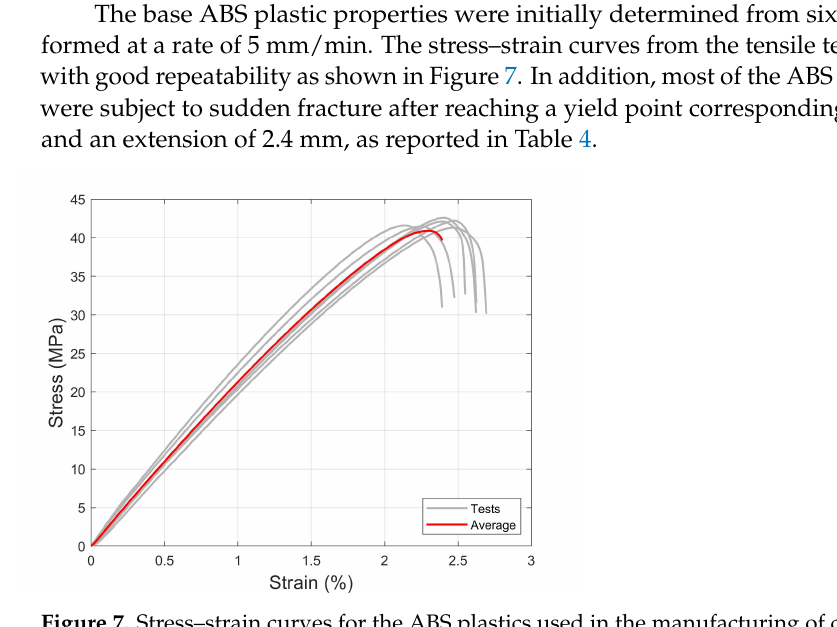
Figure 7. Stress–strain curves for the ABS plastics used in the manufacturing of chiral structures. Table 4. Young’s modulus, uniaxial tensile strength (MPa) and the maximum strain of the 3D printing